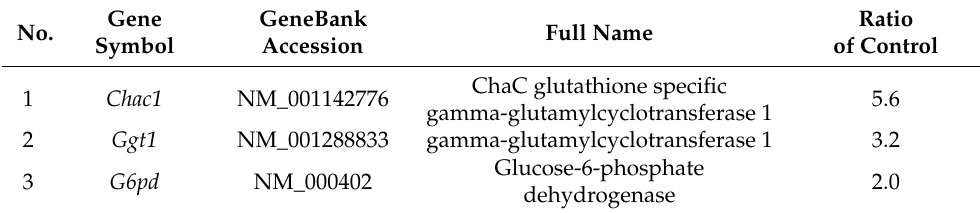
Table 1. Three genes upregulated by hydrogen peroxide in ARPE-19 cells.